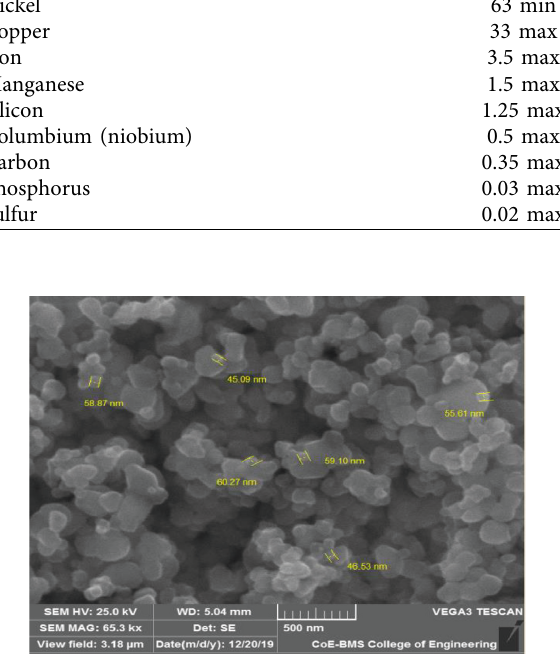
Figure 1: SEM images of TiO 2 nanoparticles. Table 2: Composition of MMCs for different